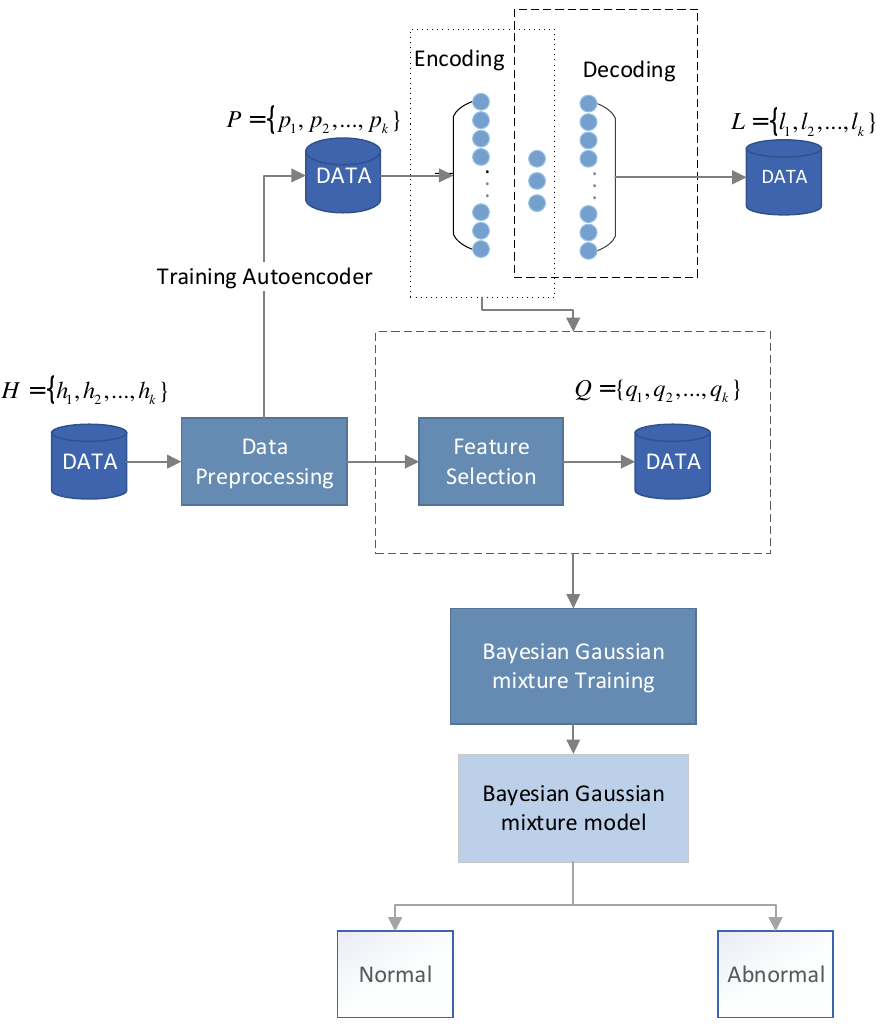
Figure 1. Autoencoder Bayesian Gaussian mixture